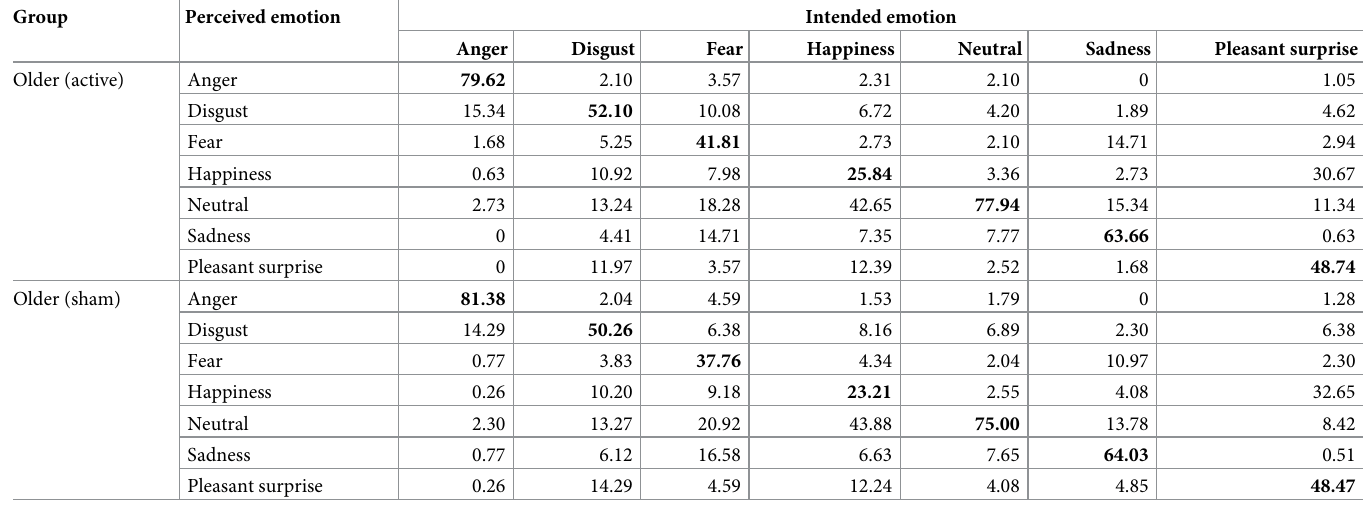
Table 3. Confusion matrix displaying patterns of average response accuracy (in %) per emotion category, per tRNS condition (active, sham), for older adults. Group Perceived